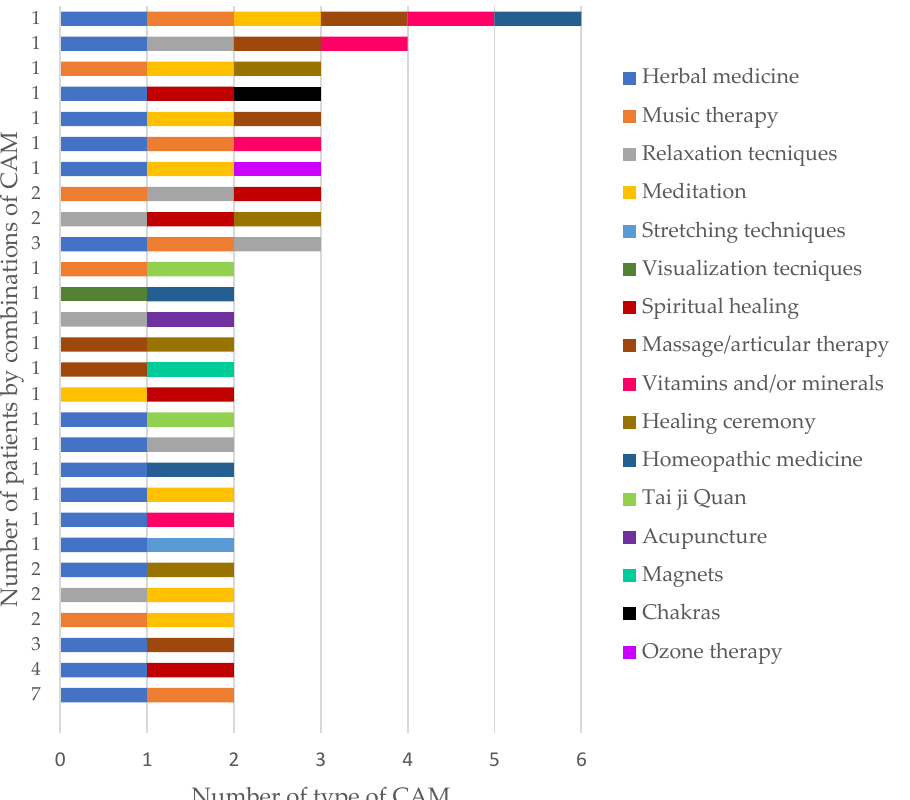
Figure 2. Combinations of type of complementary and alternative medicine (CAM) employed by the patients.